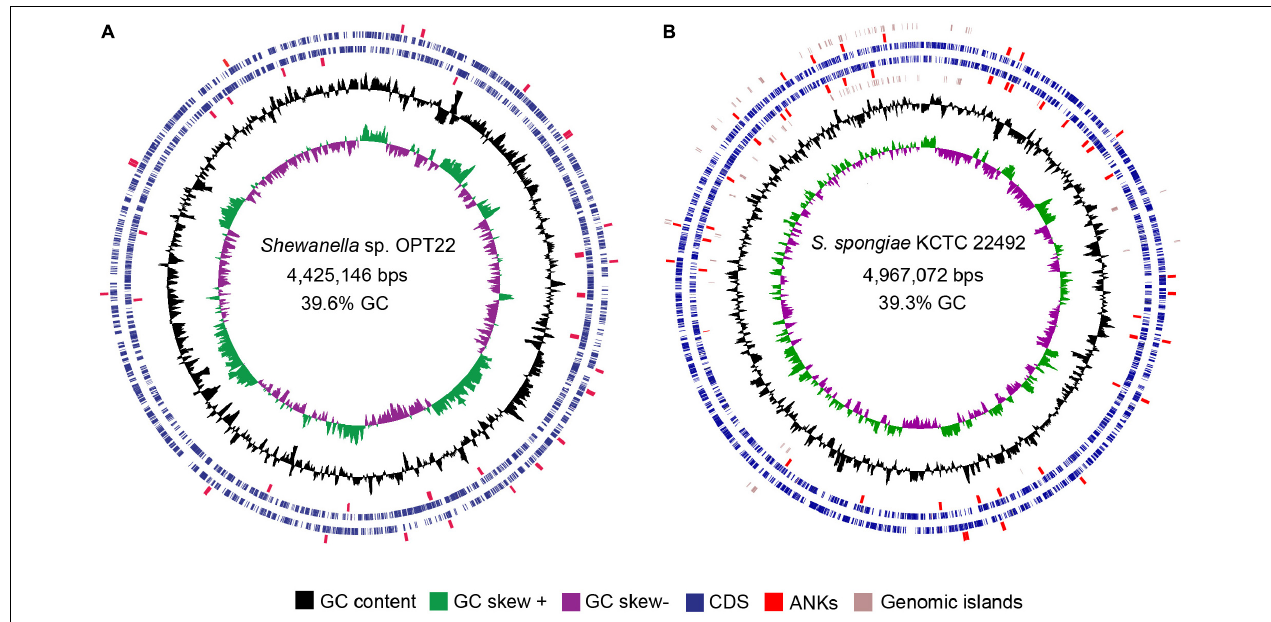
FIGURE 3 | Circular view of the genomes of two sponge-associated Shewanella species, generated with CGview (Stothard and Wishart, 2005). The genome map of (A) Shewanella sp. OPT22 sequenced in this study, isolated from an Atlantic sponge, O . papilla (B) S. spongiae KCTC 22492 isolated from an Eastern Sea (Korea) marine sponge. Circles from interior to exterior represent GC skew and GC content (black circle). Blue circles denote the coding sequences on forward and reverse strands. GIs are represented as brown circles in the genome of S. spongiae KCTC 22492. The ankyrin-repeat domains containing proteins detected in the genomes are highlighted in red.